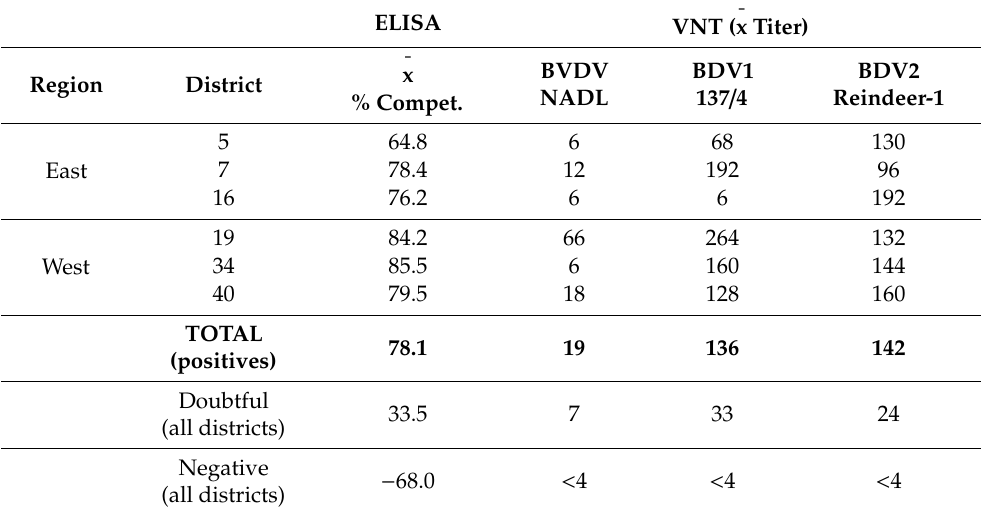
Table 4. Virus neutralization test of reindeer sera samples for ruminant